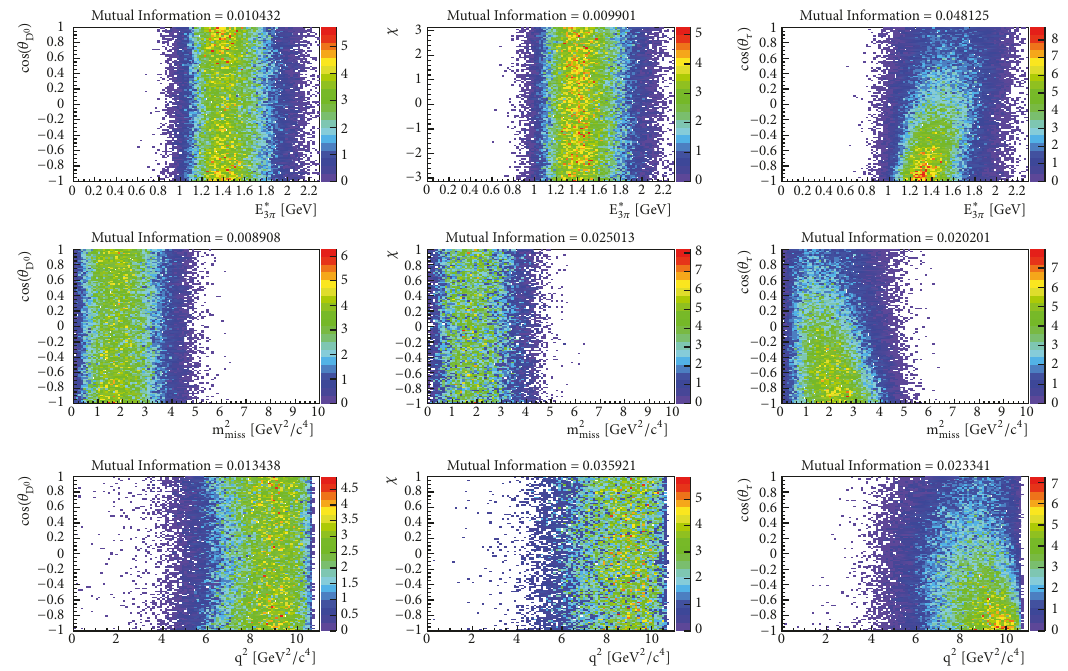
Figure 11: Mutual information between angular and discriminating variables, for 𝐵 󳨀→ 𝐷 ∗+ 𝜏 − (󳨀→ 𝜋 + 𝜋 − 𝜋 − ] 𝜏 ) ] 𝜏 decays.